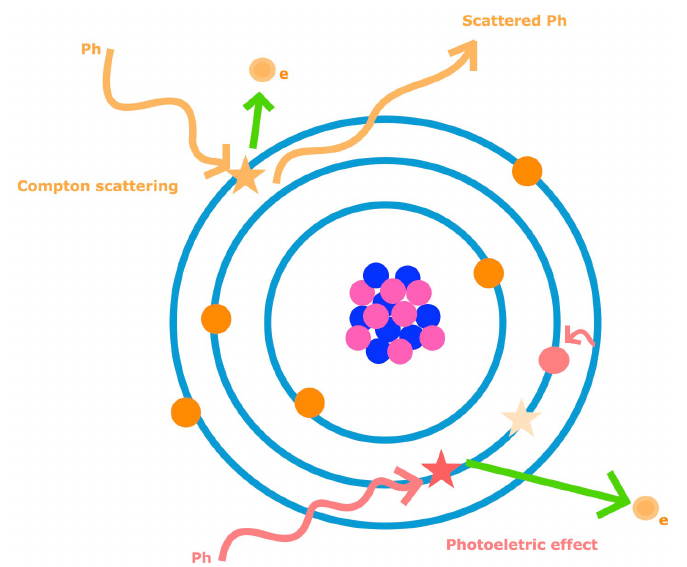
Figure 2. Schematic representation of the photoelectric effect and Compton scattering. The photoelec- tric effect is the ejection of an inner K-shell electron (e) of an atom consequent to the interaction of an incident photon (Ph), with subsequent filling of the void by an adjacent shell electron (curved arrow). Compton scattering is the ejection of an outer shell electron (e) of an atom by an incident photon (Ph), resulting in photon scattering with some energy reduction.